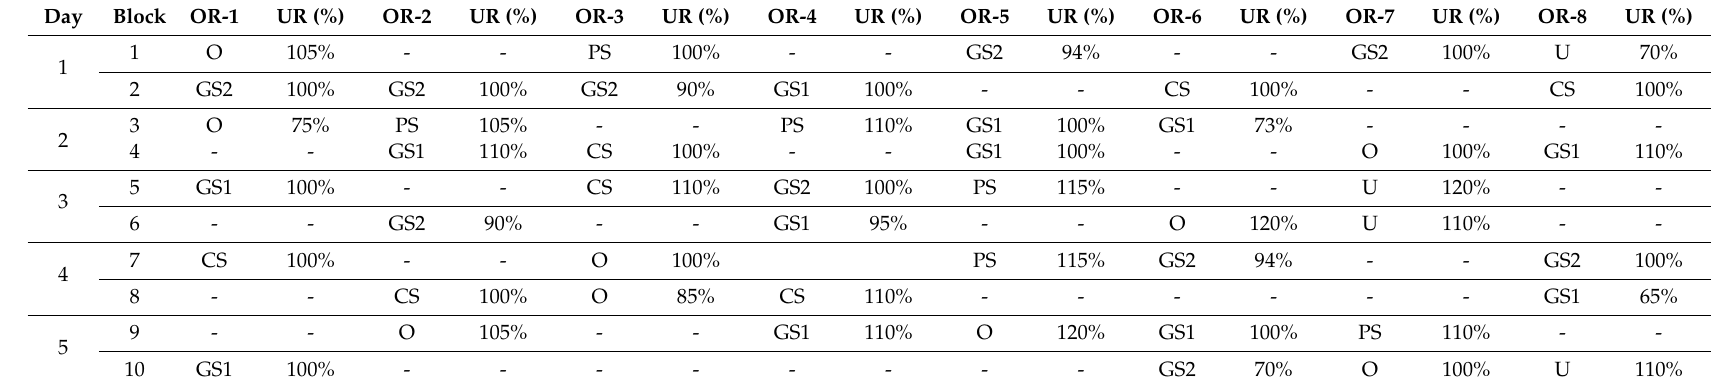
Table 3. Created schedule for Scenario 2 as a result of the goal programming